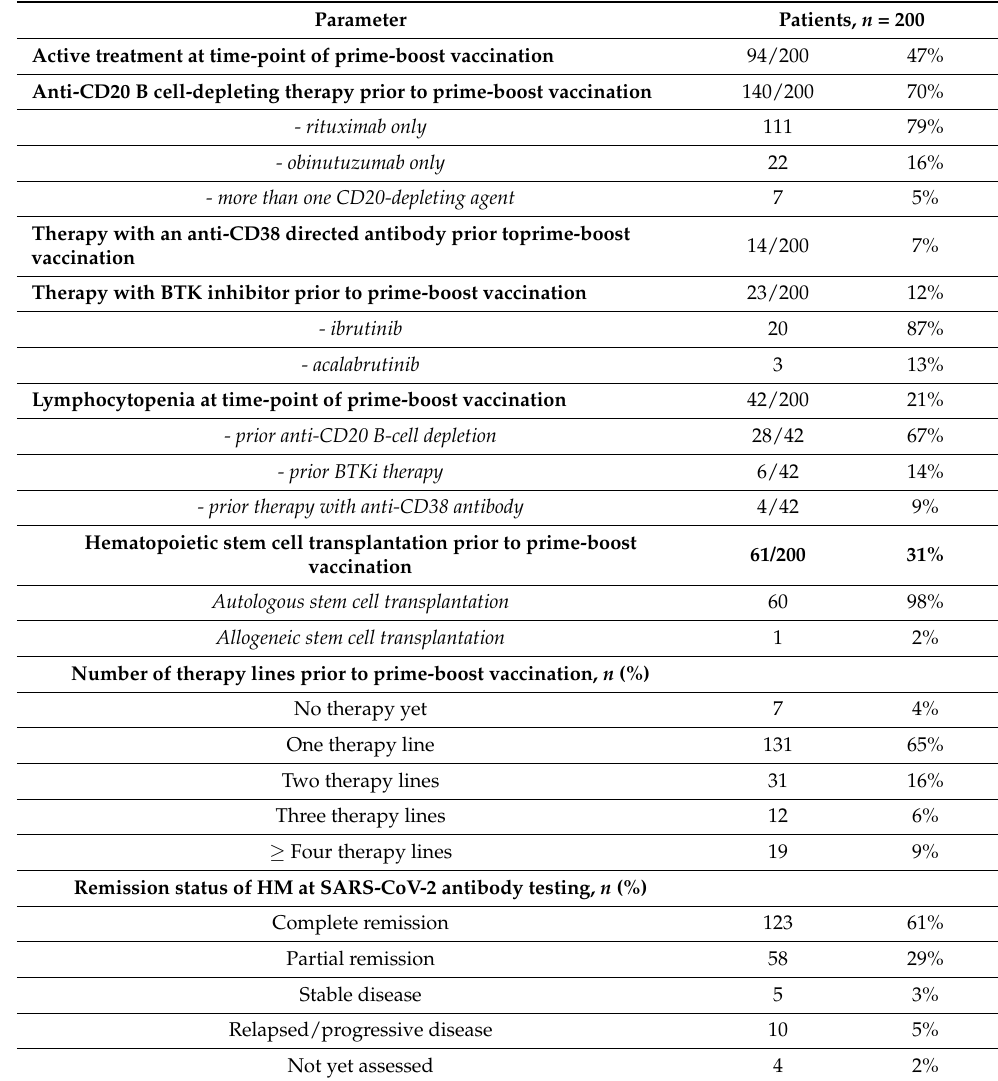
Table 1. Cont. Parameter Patients, n = 200 Active treatment at time-point of prime-boost vaccination